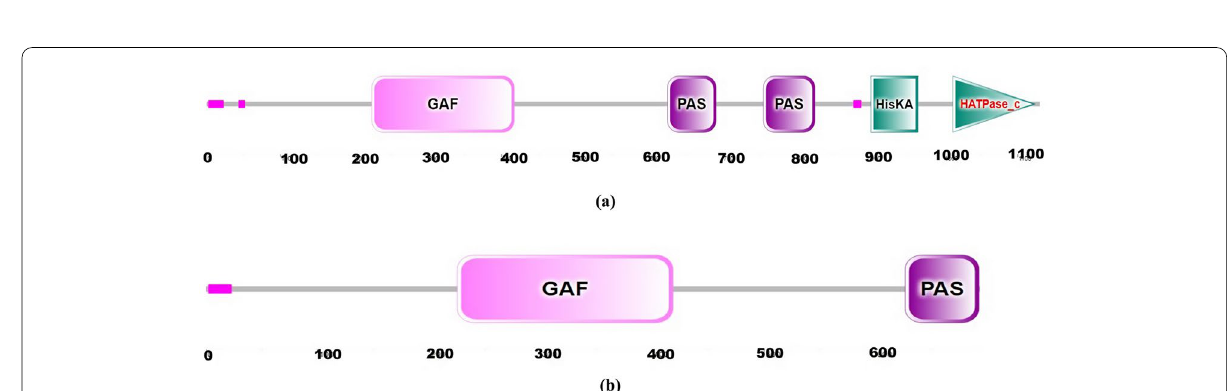
Fig. 4 a Domain structure analysis of amino-acid sequence for GmPHYA3 . b Domain structure analysis of exon-1 of LprPHYA3. The numbers represent position of amino acid. The domains for PHYA3 protein included GAF (cGMP-specific phosphodiesterase–adenylyl cyclase–FhlA), PAS (period–ARNT–single-minded) and Histidine kinase-related domains (HKRD) viz ., HisKA and